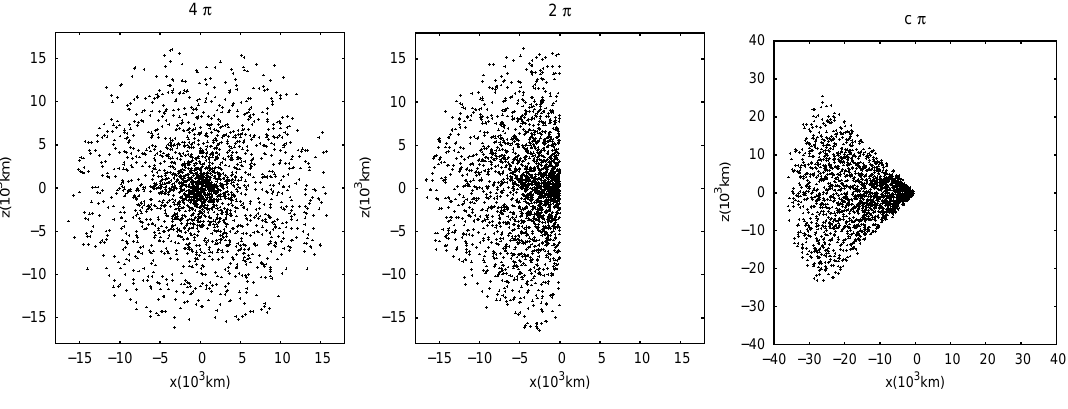
Fig. 2. Snapshot of the comet outgassing patterns for the three investigated cases at a heliocentric distance of 1.30AU. At each time step the hybrid code generates particles according to these patterns. The solar wind enters the box from the left side in +x-direction. On the left we have the spherically symmetric, in the middle the day side restricted and on the right the cone shaped model. We plot the polar plane of our coordinate system. The concentration of particles on the sun illuminated side is clearly visible. Notice the larger scale in the cone shaped model.